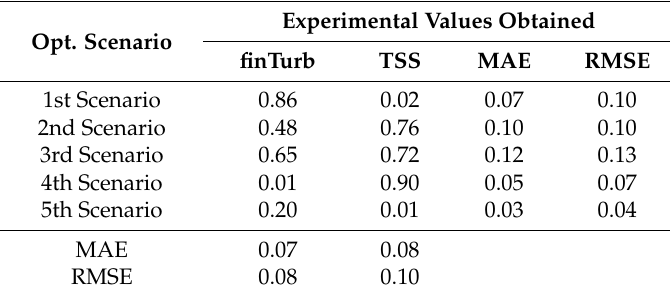
Table 19. Experimental outputs that were obtained according to the five clarification optimization scenarios for ECOTAN BIO 90D.